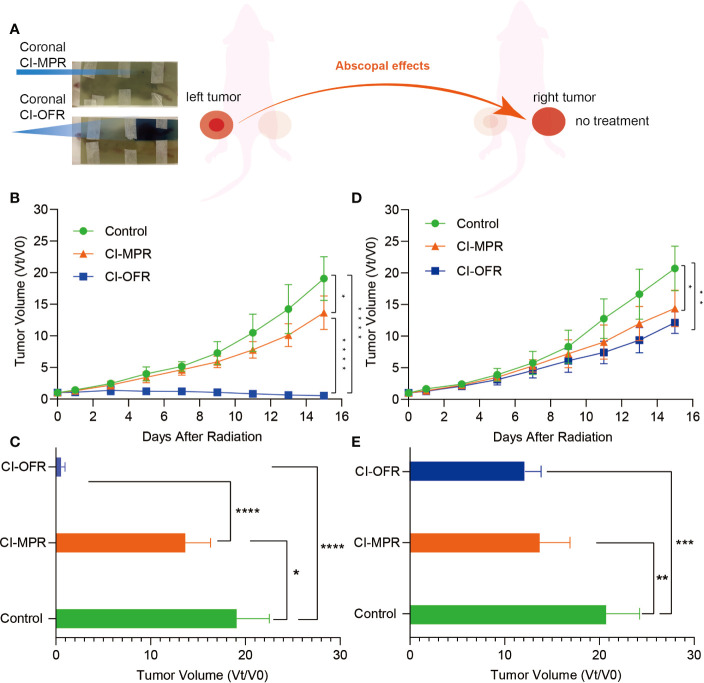
The response after irradiation on EBT3 film and evaluation of tumor volume change of the irradiated and unirradiated tumors. (A) The response and one vertex of irradiation could be noted in carbon ion open field radiation (CI-OFR) and carbon ion microporous radiation (CI-MPR) group on the EBT3 film, respectively. (B) Tumor volume change on left side (irradiated) during the observation, and p <0.05 and 0.0001 are indicated by * and ****. (C) Tumor volume change on right side (unirradiated) during observation, and p <0.05 and 0.01 are indicated by * and **. (D) Quantitative analysis of irradiated tumor (left side) volume change on day 15. (E) Quantitative analysis of unirradiated tumor (right side) volume change on day 15. Each bar represents the standard error, and p <0.05, 0.01, 0.001, 0.0001 are indicated by *, **, ***, ****.